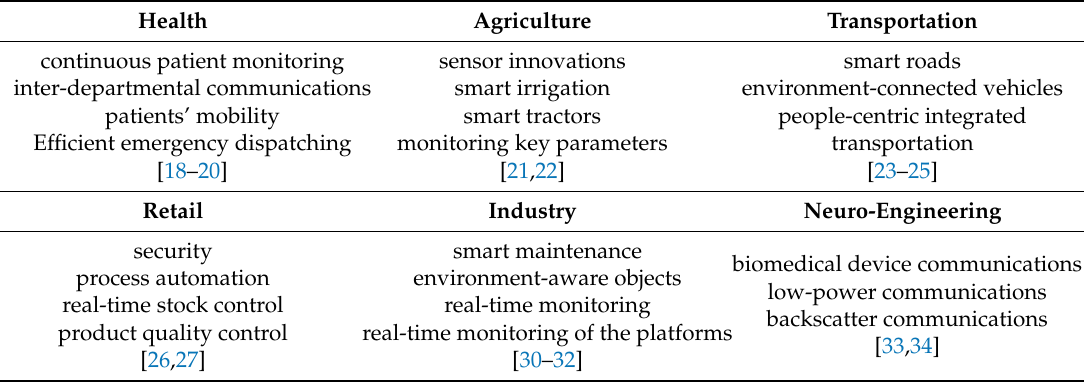
Table 1. Overview of the main areas of application of RFID sensing, including some state of the art examples for each